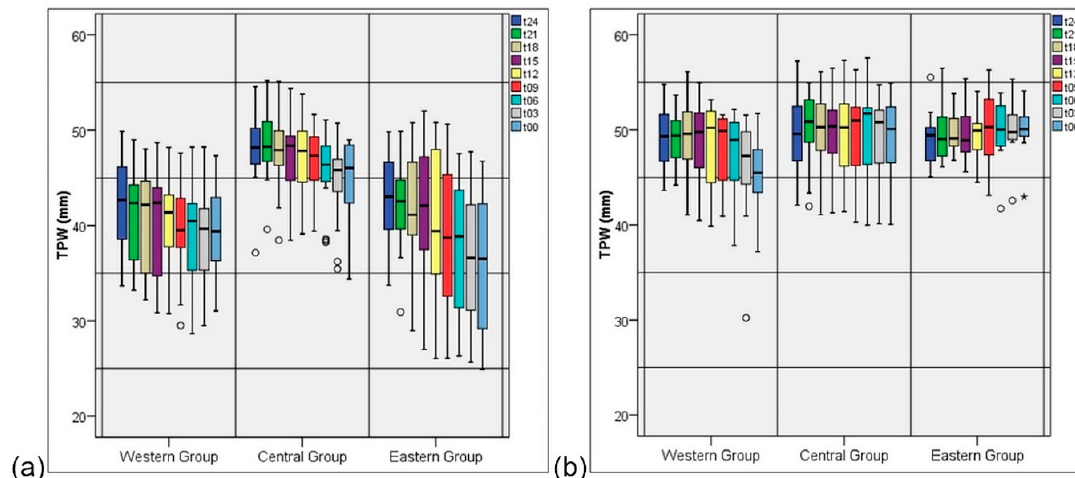
Figure 9. Boxplots for the averaged total TPW on the ( a ) left side and ( b ) right side of the storm by regional groups every three hours in the day prior to landfall. Circles (stars) denote values at least 1.5 (3) times the interquartile range. Table 4. Mann–Whitney U Test p -values for averaged total TPW on the left (cells 1, 4, 7) and right (cells 3, 6, 9) side of the storm every three hours until landfall.